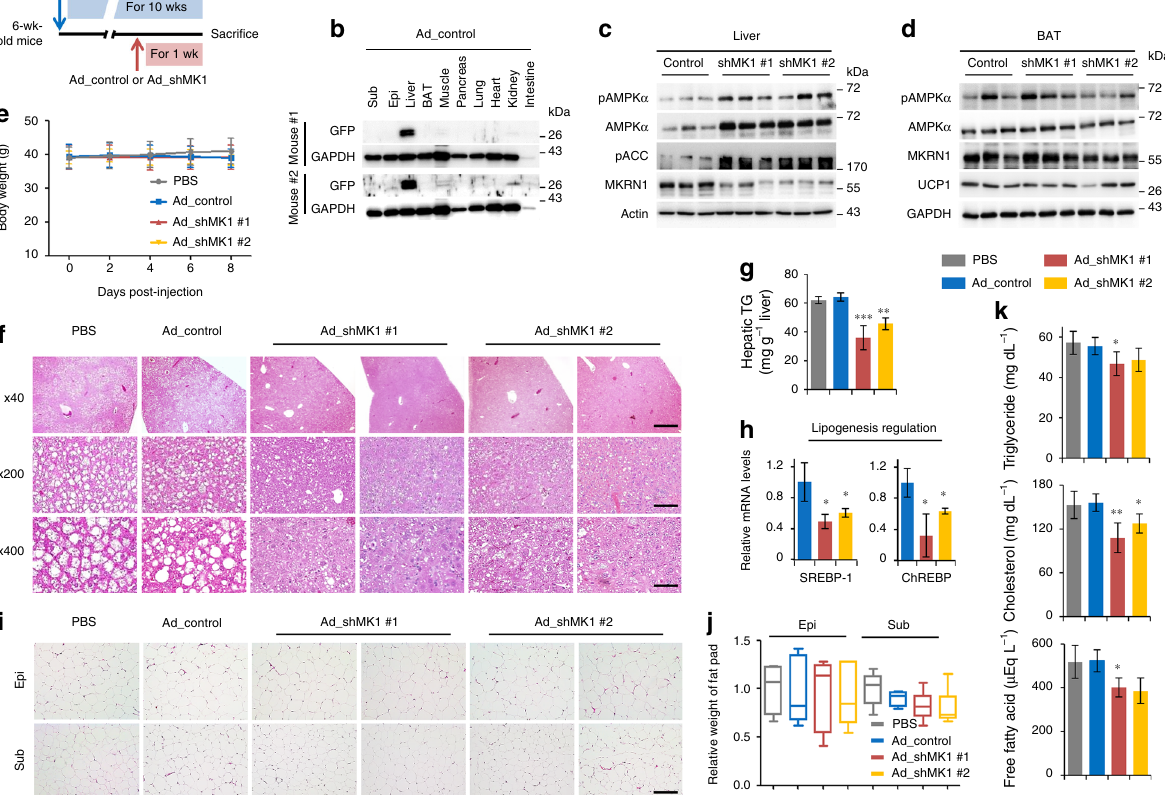
Fig. 6 Ablation of hepatic MKRN1 improves hepatic steatosis in diet-induced obese mice. a Male B6 mice (6 weeks old) were fed an HFD for 9 weeks and then injected with either PBS or adenoviruses expressing GFP via the tail vein (Ad_control, Ad_shMK1 #1 and #2 (shRNA targeting MKRN1)). After 1 week of continuous HFD feeding, the mice were sacri fi ced and analysed. b Immunoblot analysis of GFP expression in extracts from the indicated tissues (Sub subcutaneous fat, Epi epididymal fat) of mice infected with adenovirus ( n = 2). c , d Liver ( e ) and BAT ( d ) lysates from adenovirus-injected mice were analysed by immunoblotting as indicated. e Body weights of male mice fed with an HFD were measured in every 2 days for 8 days ( n = 5 mice per group). f Representative H&E staining of liver sections. Scale bar = 50, 100 and 500 µ m. g Liver TG levels were measured. h Lipogenic enzymes were analysed via quantitative real-time PCR ( n = 5 mice per group). i Representative H&E staining of epididymal fat (top) and subcutaneous fat (bottom) sections. Scale bar = 500 µ m. j The weights of fat tissues were recorded following sacri fi ce. k Liver TG levels ( n = 5 mice per group). Plasma lipid (TG, cholesterol and FFA) concentrations in 24-h-fasted mice ( n = 5 mice per group). The data are presented as the mean ± s.d. Two-tailed Student ’ s t -test; * P ≤ 0.05, ** P ≤ 0.01, *** P ≤